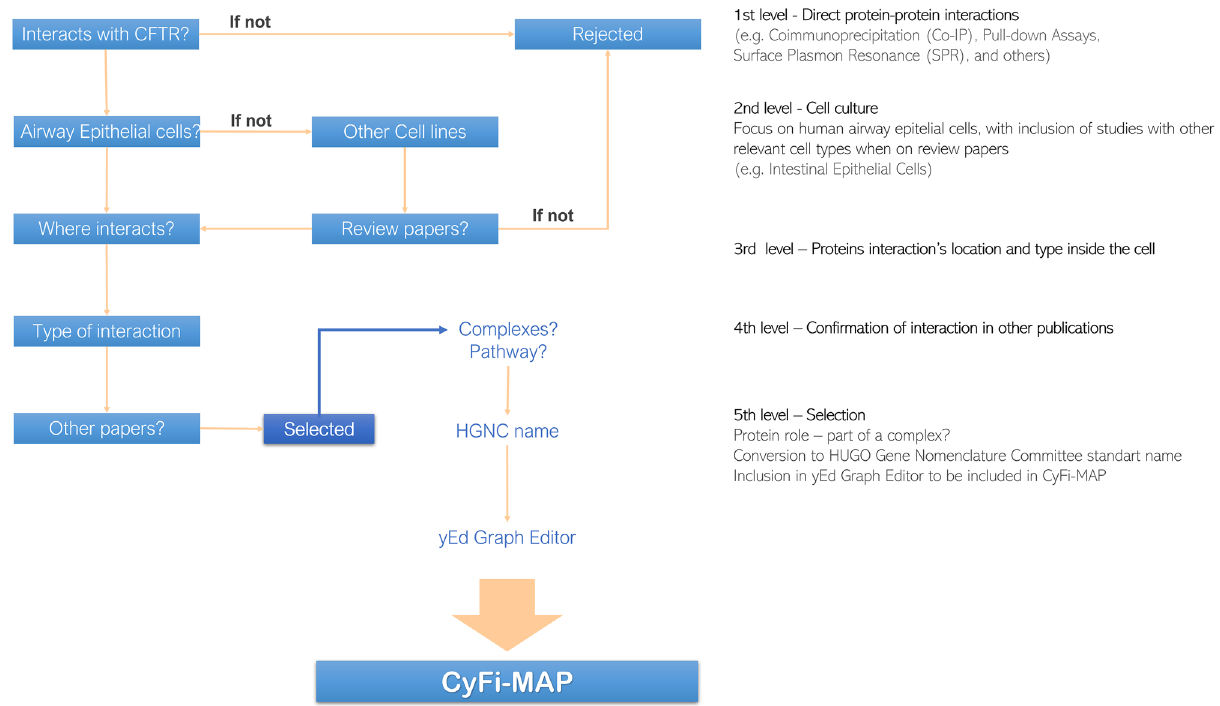
Figure 9. CyFi-MAP curation process. The curation process developed presents 5 levels. 1st level filter the data to studies with proteins that interact directly with CFTR, meaning that only experimental techniques which confirmed a direct interaction were considered such as e.g. Immunoprecipitation, Surface Plasmon Resonance (SRP), and others. The 2nd level is related to the type of cell culture used in these experiments, focusing on human airway epithelial cells, although other cell types were included when described on review publications. In both levels, if the studie do not agree with the criteria is rejected. The 3rd level consist on finding the